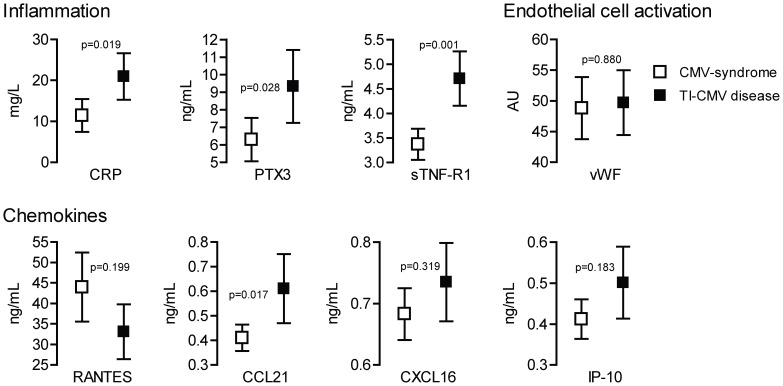
Markers of inflammation in relation to CMV-disease.Plasma levels of markers of inflammation, marker of endothelial cell activation and chemokines in relation to clinical manifestation of CMV disease as either CMV syndrome or tissue invasive CMV disease. The P-values are adjusted for potential confounders (i.e., age, sex, viral load and time from transplantation). TI, tissue invasive. P-values <0.00625 were considered significant to account for multiple testing (see Methods). Data are given as mean and 95% CI.